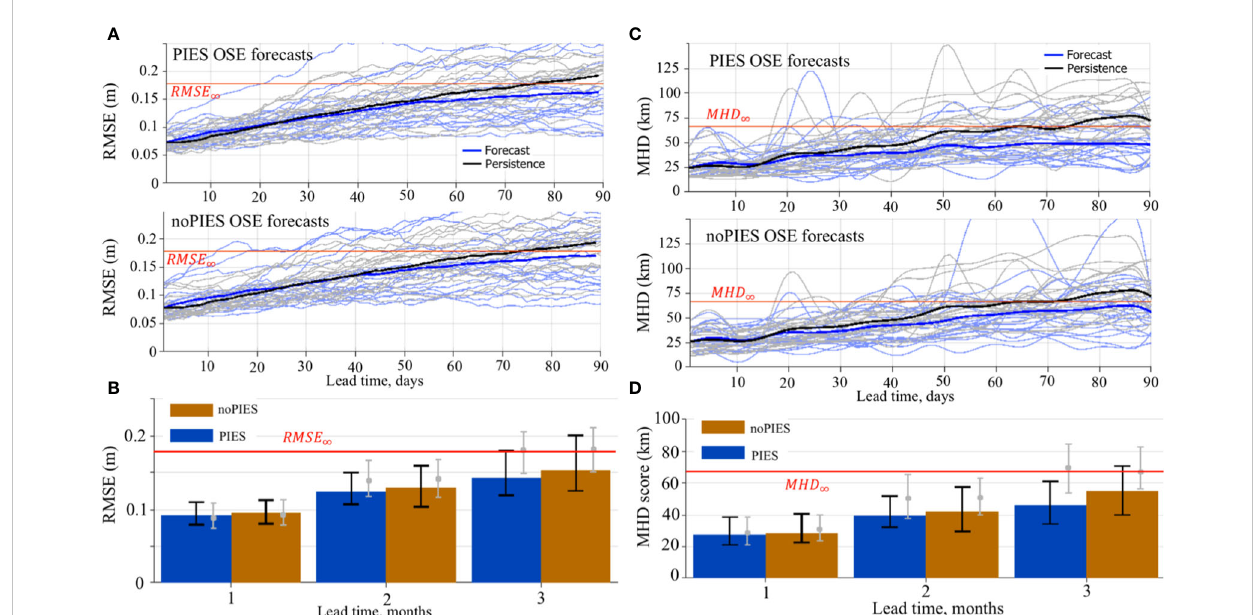
FIGURE 6 (A, B) RMSE (m) between SSH from the forecasts initialized from the “ PIES ” and “ noPIES ” OSE analysis runs and SSH from the 0.04GOM reanalysis. (A) RMSE of the individual 3-month forecasts (light blue) and corresponding persistency prediction (grey lines). The bold blue line is the mean RMSE over all individual forecasts. The black is the mean RMSE of persistency forecasts. The horizontal red line indicates RMSE ∞ (95% of the saturation value). (B) The median (the colored bars) and the IQR (the black vertical lines) of the RMSE. The RMSE are grouped by the forecast months. The grey bullet and the vertical lines indicate the median and the IQR of the RMSE between the persistence and the 0.04GOM reanalysis. (C, D) MHD scores (km) of the OSE forecasts. The MHD is computed for the LC/LCE fronts derived from the SSH fi elds of the OSE forecasts and the 0.04GOM reanalysis. (C) MHD scores of the individual 3-month forecasts (light blue) and corresponding persistency prediction (grey lines). The bold blue line is the mean MHD over all individual forecasts. The black is the mean MHD of persistency forecasts. The horizontal red line indicates MHD ∞ . (D) Median (bars) and the IQR (the black vertical lines) of the MHD scores of the OSE forecasts grouped by the forecast months. The grey bullet and the vertical lines indicate the median and the IQR of the MHD of the